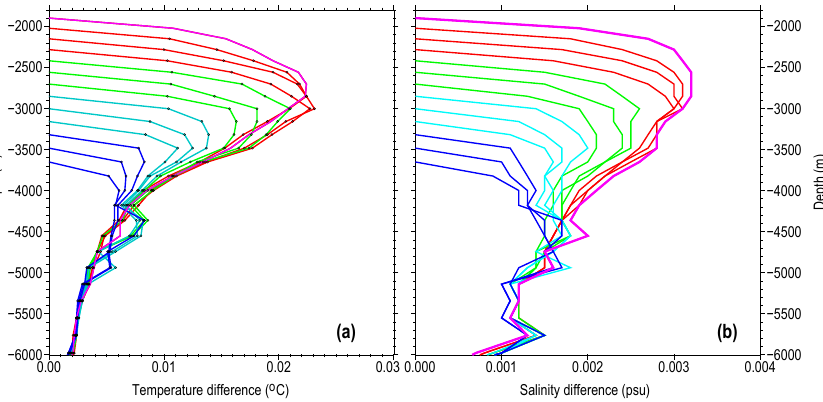
Figure 4. Mean absolute difference between the observed and extrapolated profiles for temperature (a) and salinity (b) at different merging depths. The intersection of each difference profile with the y axis corresponds to the respective merging